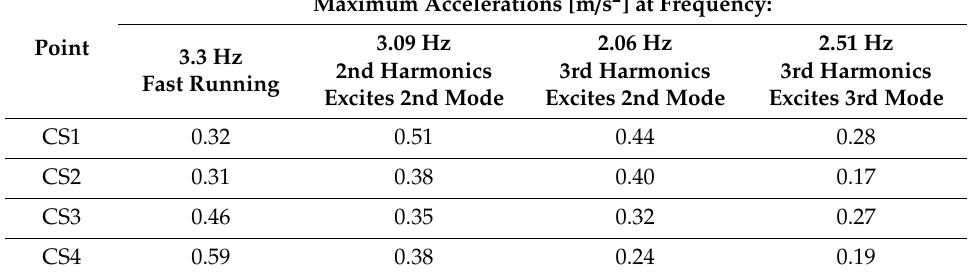
Table 10. Maximum vertical accelerations generated by a single pedestrian running obtained at the representative points of the cable-stayed footbridge with the GFRP slab for the selected